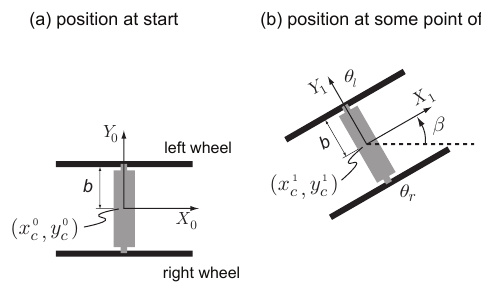
Figure 5. Steering model adapted from differential drive systems: A top view of the robot. ( a ) The world or fixed frame X 0 − Y 0 is shown to coincide with robot local frame. ( b ) The local frame X 1 − Y 1 is attached to the robot and moves with it. The steer or heading angles is β and the point C is midway between two wheels have the coordinates x 1 c , y 1 c in the local frame and x 0 c , y 0 c in the world or fixed frame. For the steering model, a differential equation for the position of C , ˙ x 0 c , ˙ y 0 c and heading ˙ β is